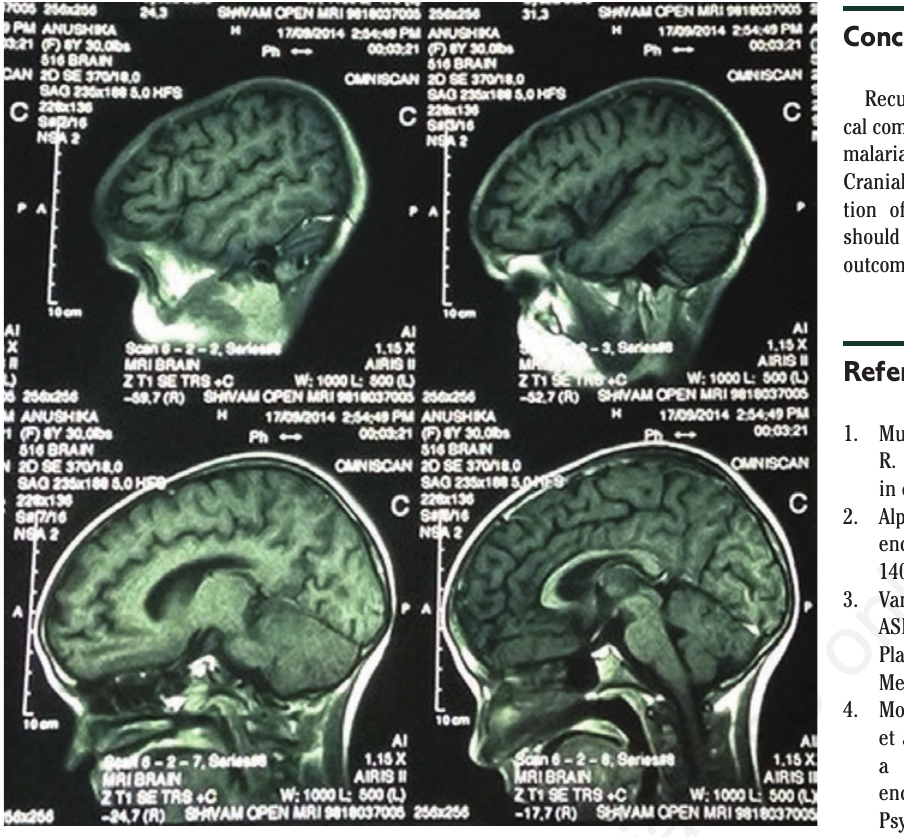
Figure 1. Magnetic resonance imaging of the brain showing high-intensity signals in sub- cortical, cortical, left parietal, periventricular regions and